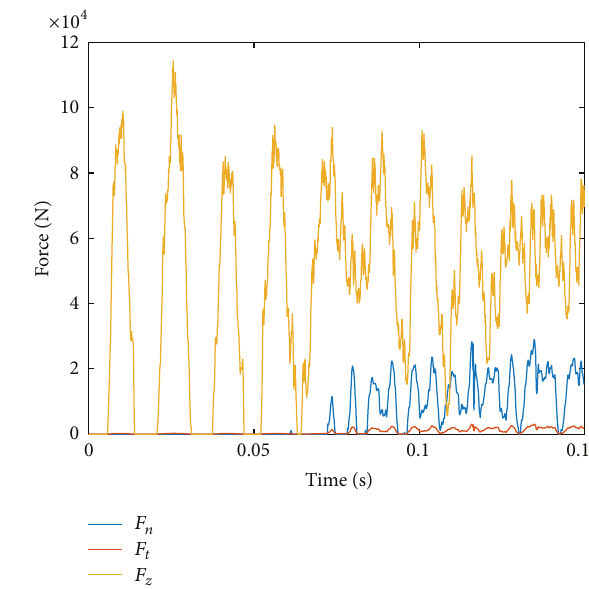
Figure 4: Measured and estimated displacements. Z -direction, experiment #11.